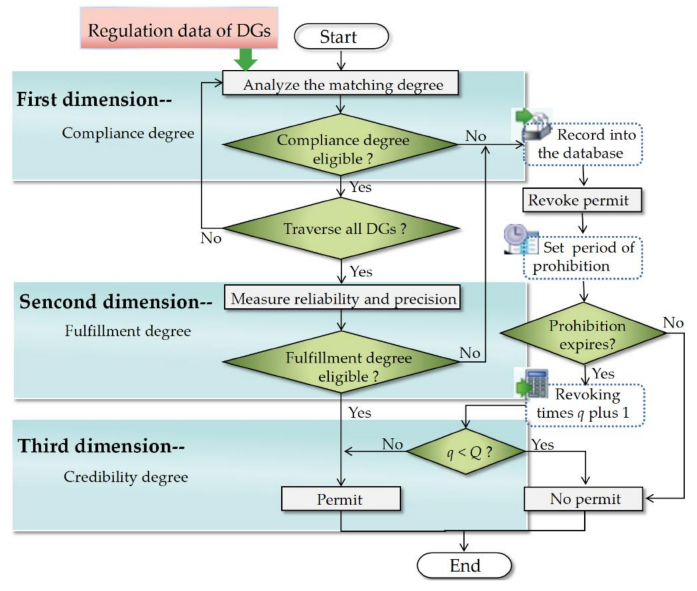
Figure 3. Self-renewal mechanism process.